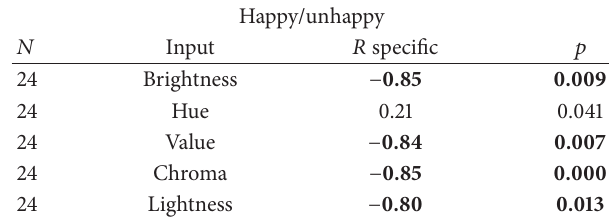
Table 1: Happiness correlation.